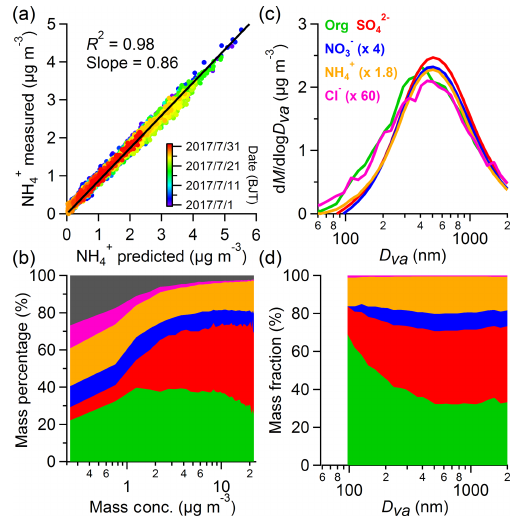
Figure 3. (a) Scatterplot and linear regression (black solid line) of measured NH + versus predicted NH + based on the mass concentra- 4 4 tions of SO 2 − , NO − and Cl − ; (b) the mass contributions of PM 1 4 3 chemical species as a function of total PM 1 mass concentration; and the average size distributions of (c) mass concentrations and (d) mass contributions of NR-PM 1 species in this